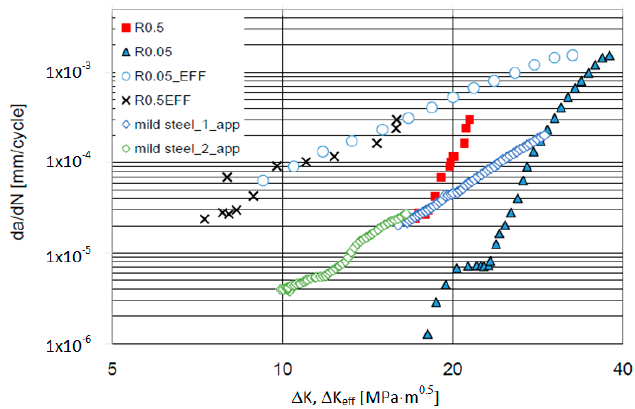
Figure 8. Fatigue crack growth rate of Eiffel bridge puddle iron under R = 0.05 and 0.5 conditions compared with equivalent old mild steel (data from: [9]).